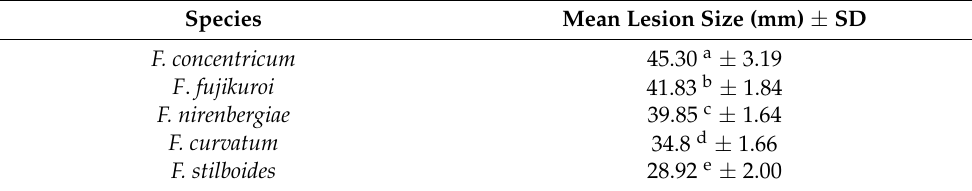
Figure 4. Artificial symptoms on tip of Dendrobium officinale stems ( A ), and Pyrus pyrifolia fruits ( B ) after inoculation with Fusarium species. Table 3. Virulence testing of Fusarium species on Pyrus pyrifolia .